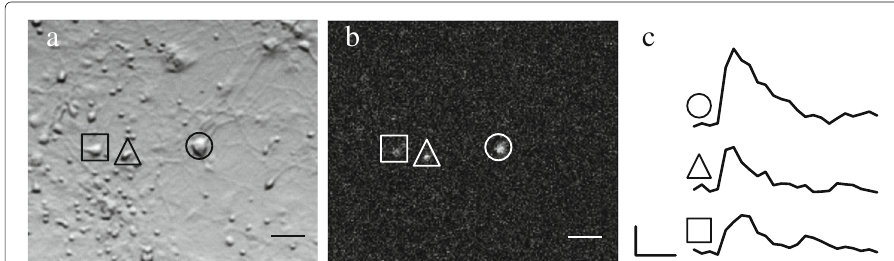
Fig. 3 Simultaneous laser scanning photostimulation (LSPS) and calcium (Ca) imaging. a Bright-field and image showing positions of photostimulated neuron ( circle ) and responding neurons ( triangle and square ).